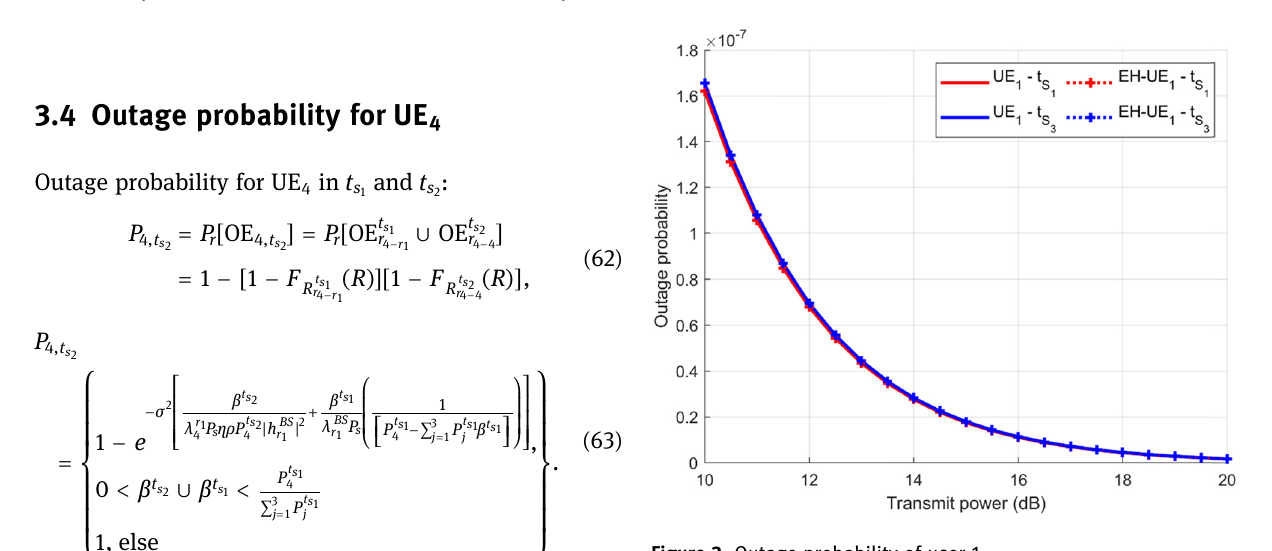
Figure 3: Outage probability of user